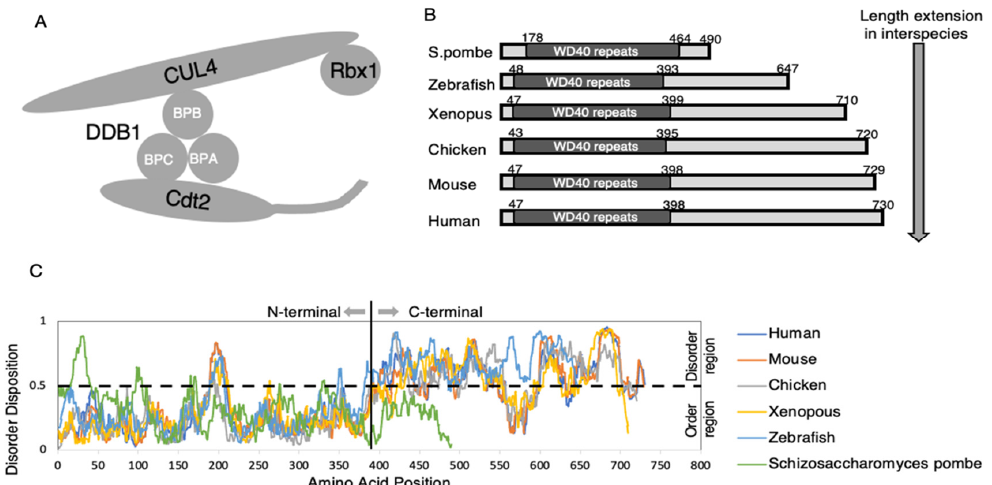
Figure 1. Schematic diagram of CRL4 Cdt2 , comparison of the extended C-terminal regions of Cdt2 from various species, and dynamic prediction analyses of the N-terminal and C-terminal portions of Cdt2 protein. ( A ) Schematic representation of the CRL4 Cdt2 complex. Shown are the substrate receptor Cdt2, the adapter protein DDB1 (BPA, BPC, BPC), a scaffold protein, CUL4, and Rbx1. ( B ) Comparison of extended C-terminal regions of Cdt2 from yeast to human. ( C ) Dynamic prediction analyses of the N-terminal and C-terminal portions of the Cdt2 substrate receptor protein. The flexible patterns in the disordered region are conserved in higher eukaryotes. Dynamic prediction analysis was performed using Predictor of Natural Disorder Regions (PONDR ® VLXT) software [16].